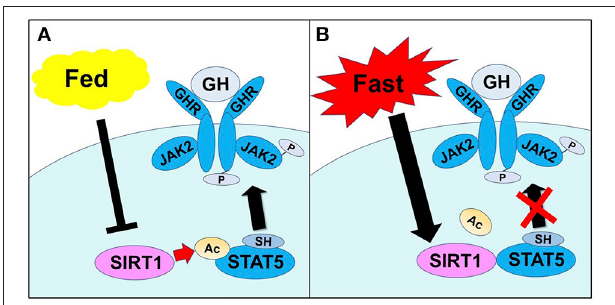
FIGURE 1 | The mechanisms through which SIRT1 regulates STAT5 activation by GH. (A) In the fed condition, the SH2 domain of STAT5 recognizes and binds to Tyr-phosphorylated GHR, causing JAK2 to phosphorylate and activate STAT5. (B) In the fasting condition, SIRT1 is activated and interacts with STAT5, thereby deacetylating Lys residues adjacent to the SH2 domain of STAT5. This results in an impaired ability to bind Tyr-phosphorylated GHR, which inhibits activation of STAT5. Excerpt from, Yamamoto et al.